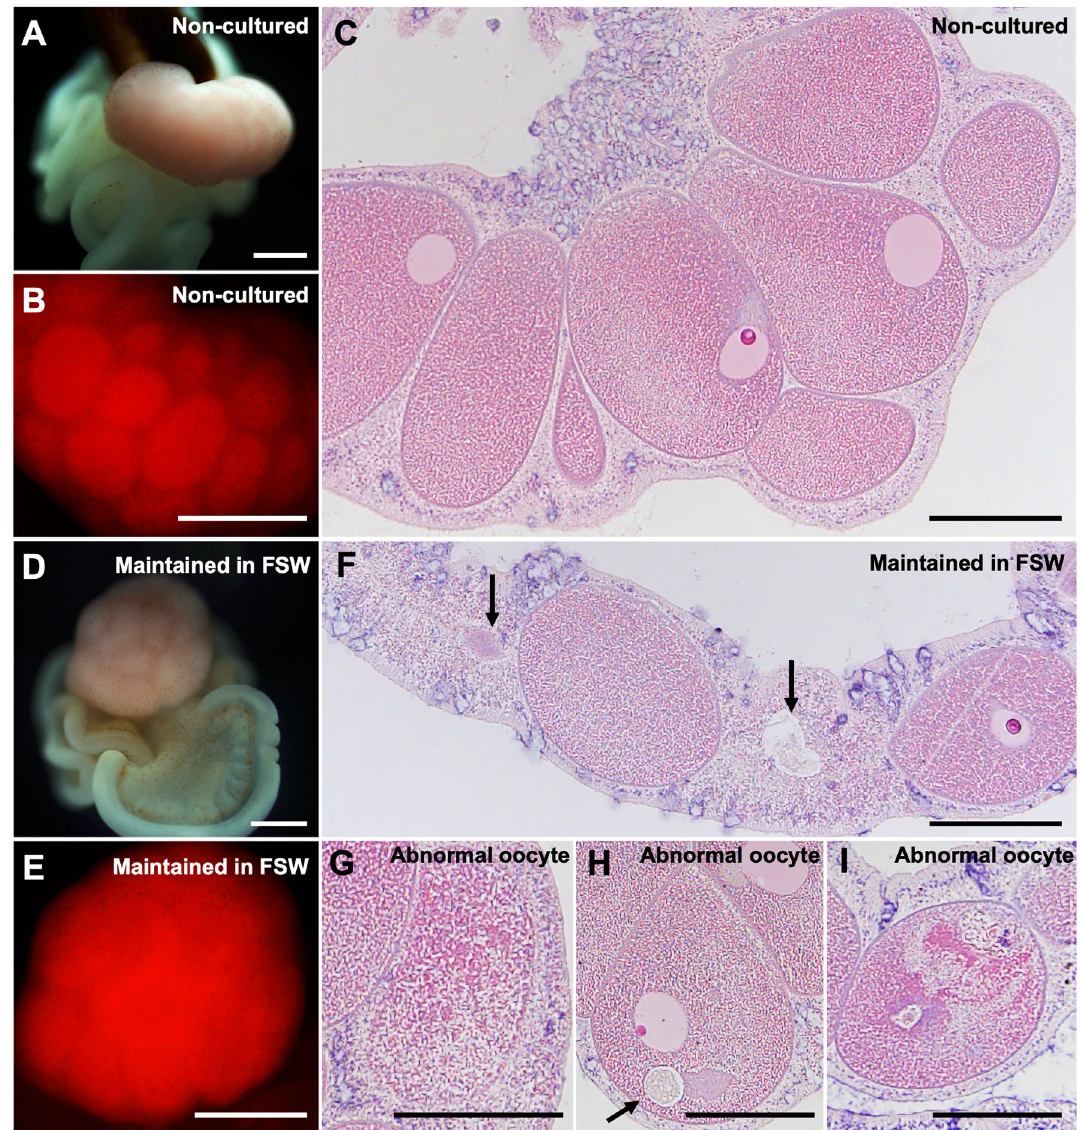
Figure 1. Morphological and histological characteristics of isolated mesenterial tissues and their changes during maintenance in FSW. ( A ) Brightfield view of freshly isolated mesenterial tissue containing an ovary and mesenterial filaments (Non-cultured). ( B ) Endogenous expression of oocyte RFP, observed with the U-MWIG 2 (RFP) filter of a fluorescence microscope. ( C ) HE section of the freshly isolated ovary (Non-cultured). ( D ) Brightfield view of mesenterial tissue maintained in FSW for 6 days. ( E ) U-MWIG 2 (RFP) filter view of an ovary maintained in FSW for 6 days. ( F ) HE section of an ovary maintained in FSW for 6 days. Oocyte disappearance was observed (arrows). ( G – I ) Morphological abnormalities in oocytes: disintegration of cell membranes ( G ), appearance of unidentified vesicles ( H ), and severe cytoplasmic deviations with unidentified vesicles ( I ). Scale bars = 500 μm ( A , B , D , E , F ); 200 μm ( C , F , G , H , I